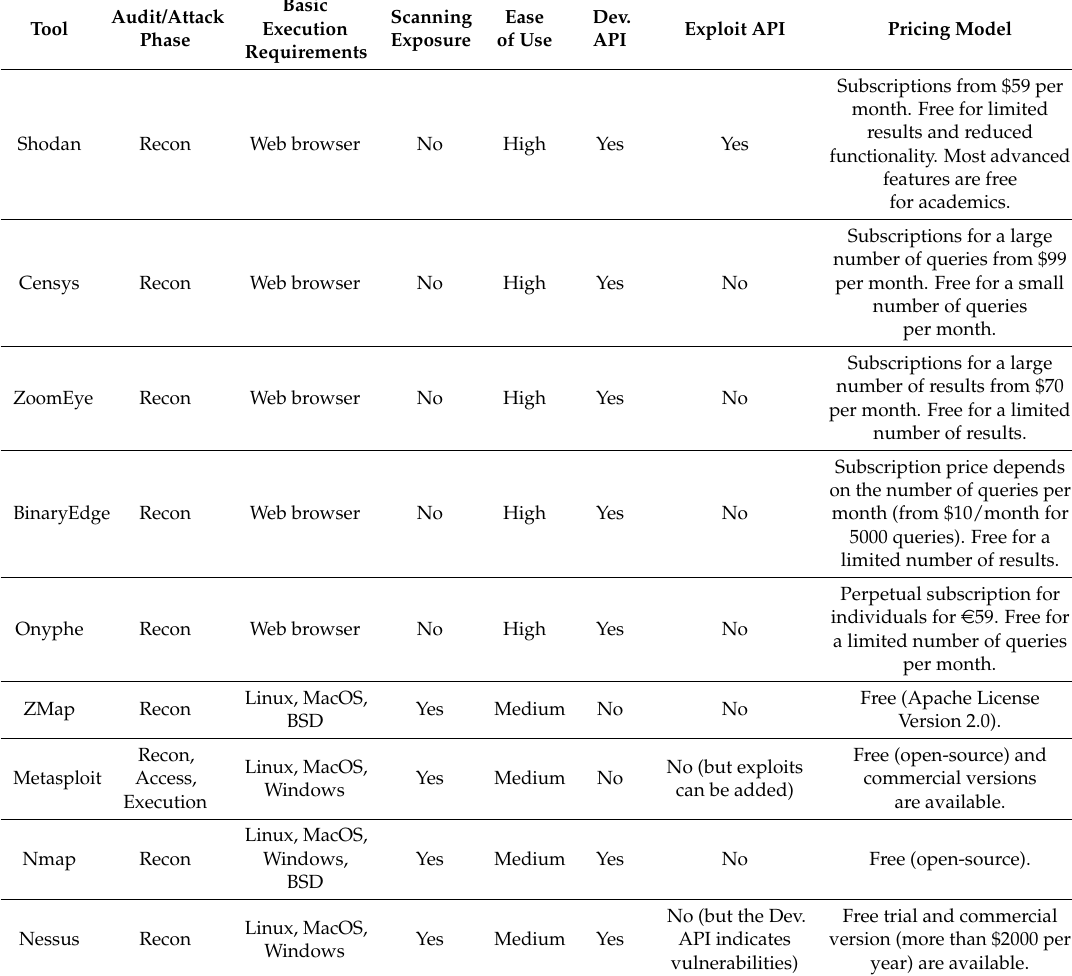
Table 2. Comparison of some of the most relevant tools for shortening the Recon